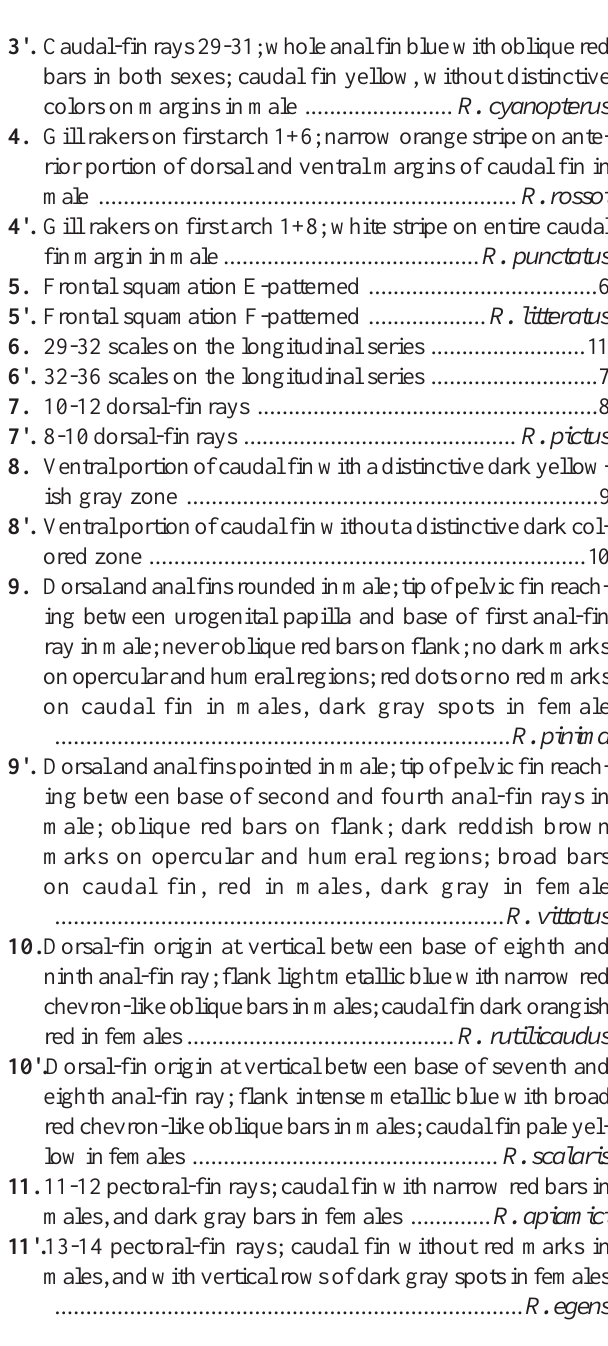
Holotype. UFRJ 5915, male, 24.3 mm SL; Brazil: Estado de Mato Grosso do Sul: Sonora, córrego Confusão, tributary to rio